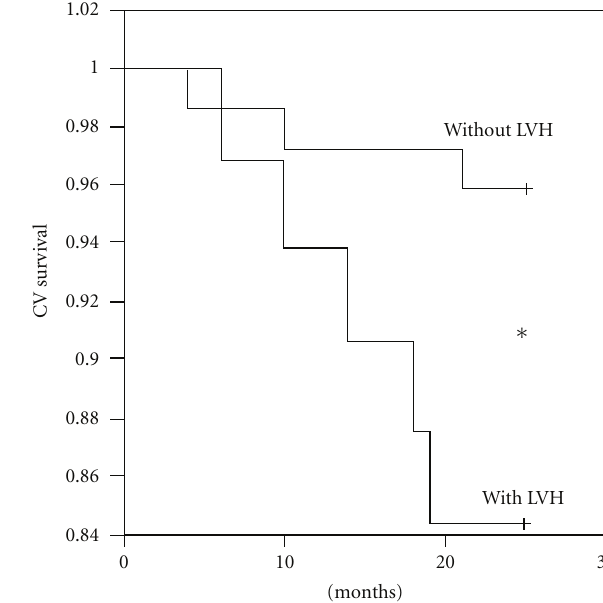
Figure 1: Kaplan-Meier analysis on whole hemodialysis patients showed that nonsmokers survived better than smokers. Log-rank test denoted that there was a significant di ff erence in mortality between smoker and nonsmoker.